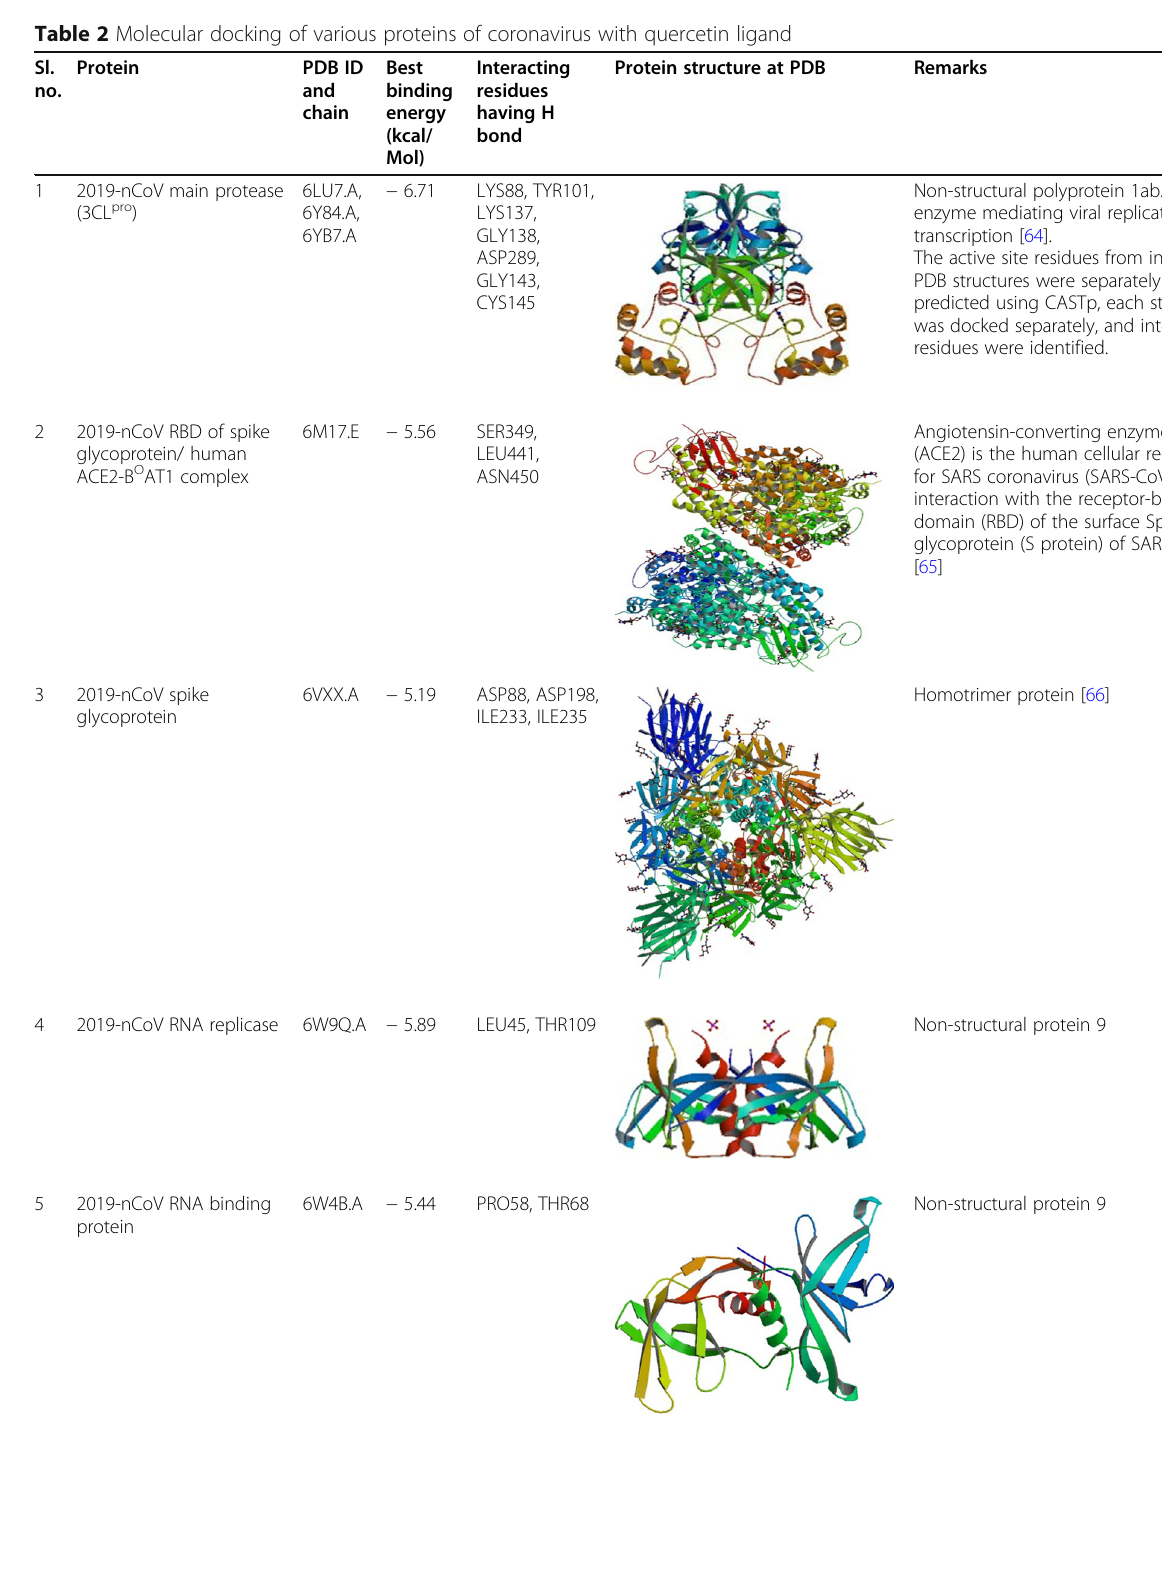
Table 2 Molecular docking of various proteins of coronavirus with quercetin ligand Sl. Protein no.